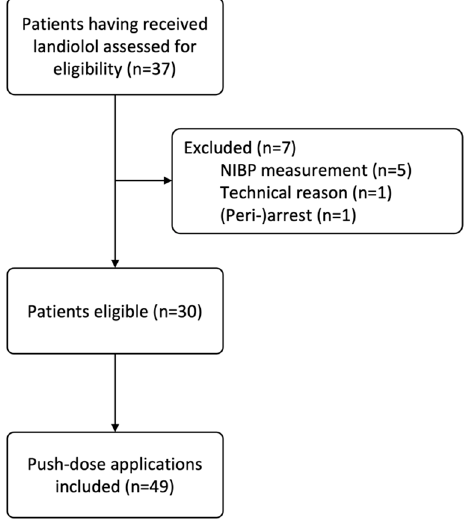
Figure 1. Flowchart of study inclusion. NIBP = non ‐ invasive blood pressure.